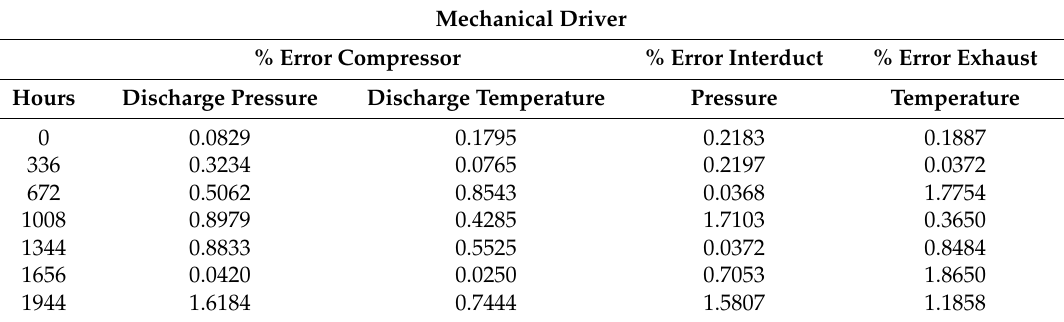
Table 4. Error between measured and simulated data at low power operation (mechanical